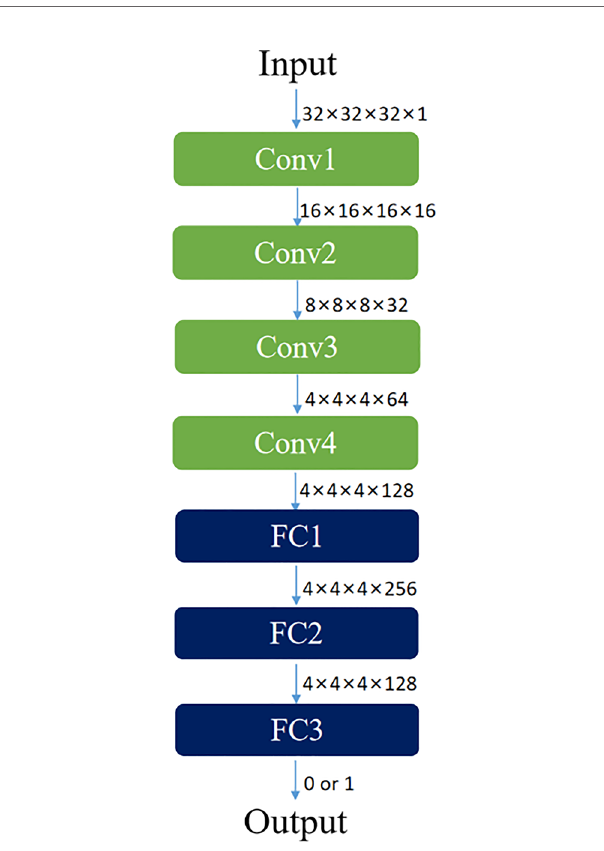
FIGURE 3 | Network structure diagram of discriminator based on